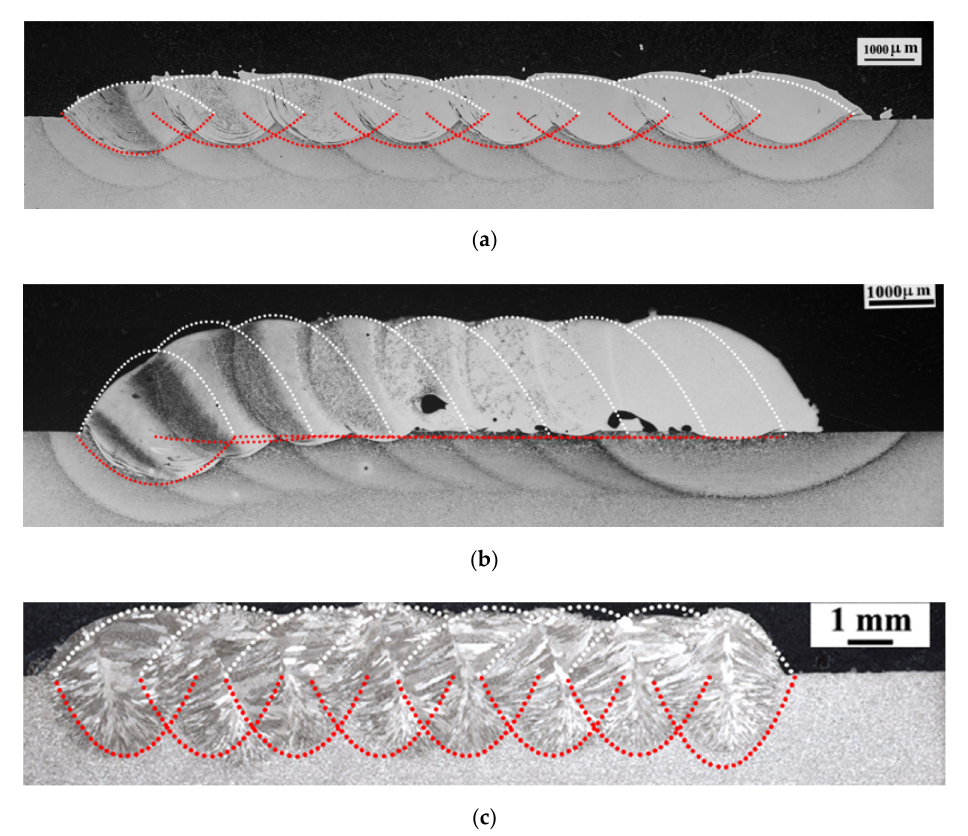
Figure 5. Comparison of the model with cross sections of real coatings: ( a ) coating of Eutroloy 16606A at 2700 W, 900 mm·min −1 , 15.6 g·min −1 , d o = 40% and continuous coaxial nozzle with a slit of 1 mm; ( b ) coating of Eutroloy 16606A at 2100 W, 500 mm·min −1 , 12.3 g·min −1 , d o = 50% and continuous coaxial nozzle with a 0.5 mm slit; and, ( c ) coating of Alloy 718 at 2500 W, 500 mm·min −1 , 18 g·min −1 , d o = 40% and four-stream nozzle.